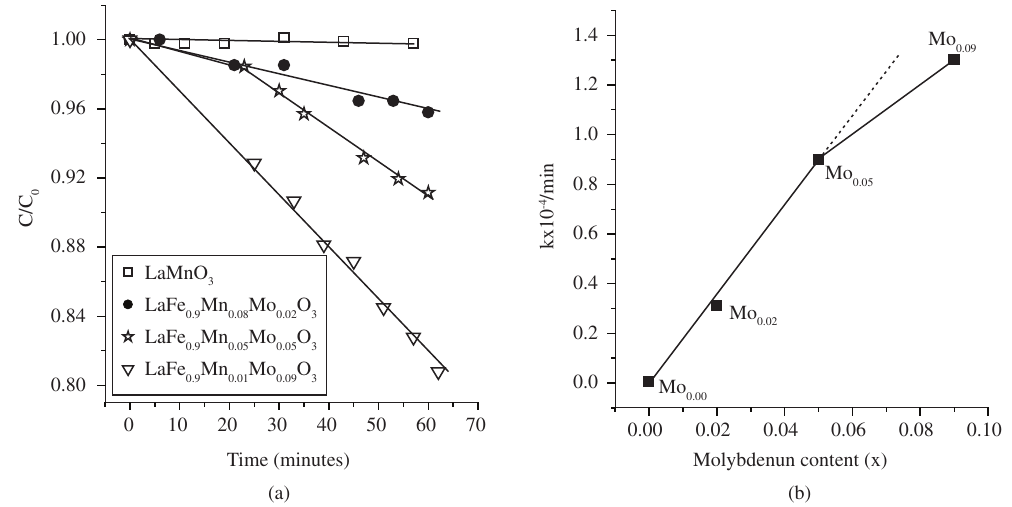
Figure 7. a) Discoloration of the dye methylene blue (0.1 g L –1 ) with H b) Methylene blue discoloration rate as function of the Mo content in the